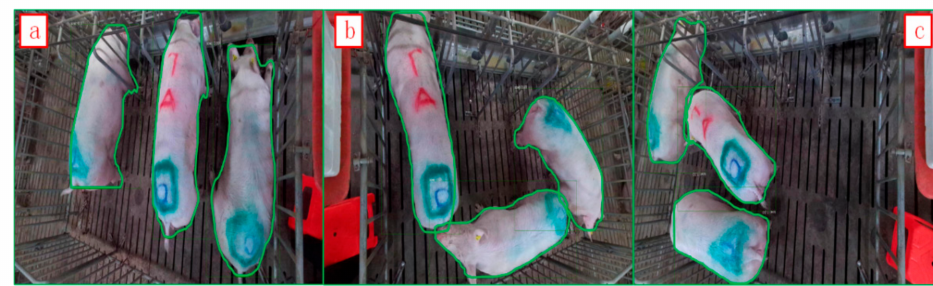
Figure 8. Target detection of Mask-RCNN: ( a ) without adhesion; ( b , c ) with adhesion. The green outline is the segmentation outcome.